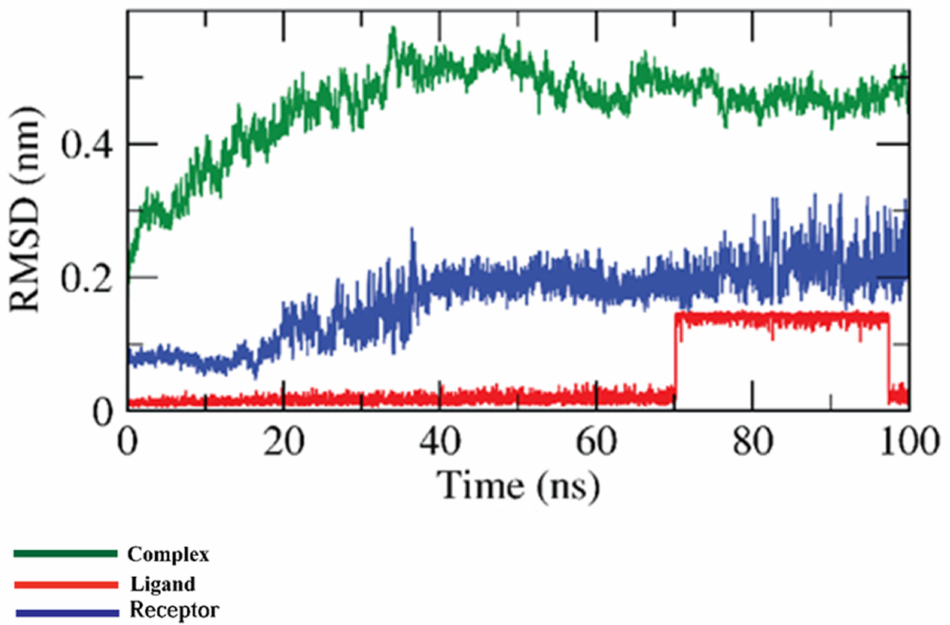
Figure 7. RMSD values of β CD-anabasine complex.